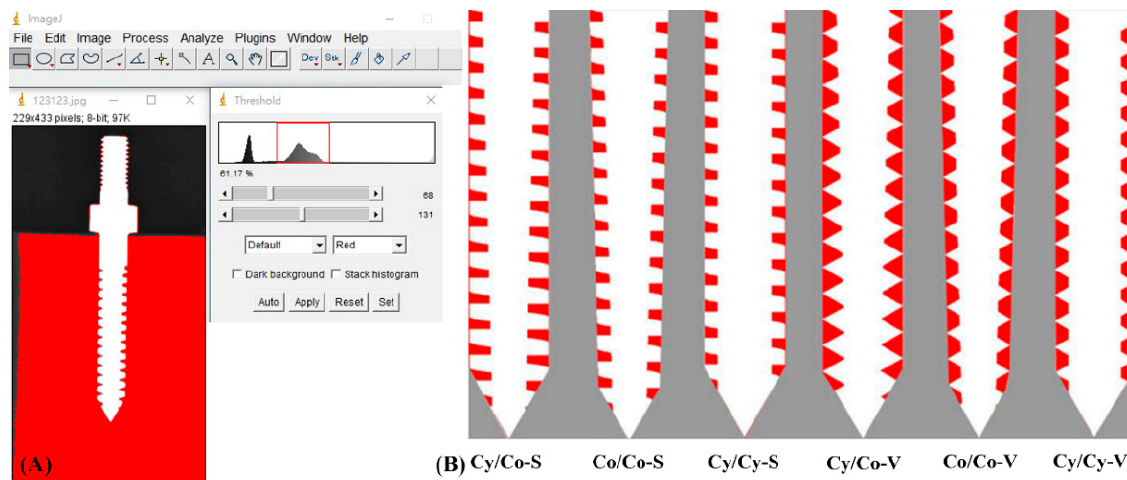
Figure 4. Photographs showing ( A ) EBV quantification conducted using radiographic imaging of inserted screws and ImageJ analysis software, and ( B ) the area of bone (highlighted) embedded in the screw threads for various screw geom- etries.